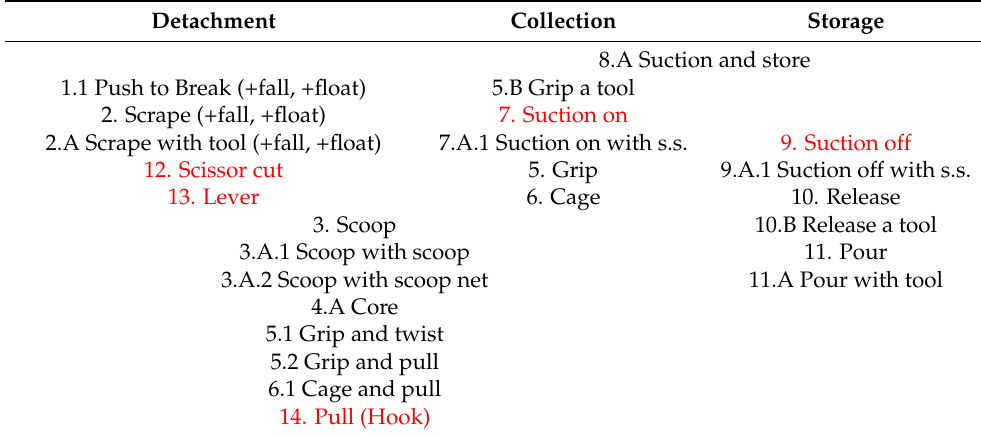
Table 3. Taxonomy of manipulative actions for marine sampling with ROV. Each record in this table is an atomic manipulation. s.s. stands for suction sampler. In red, additional actions identified in [22].